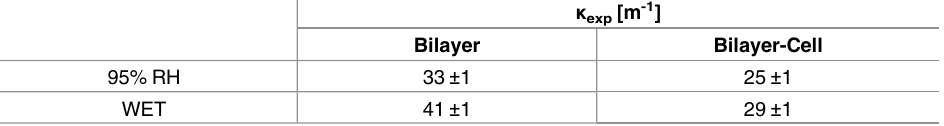
Table 3. Equilibrium curvatureof the actuated bilayer and bilayer-cell upon exposure to 95% relative humidity and wetting with liquid